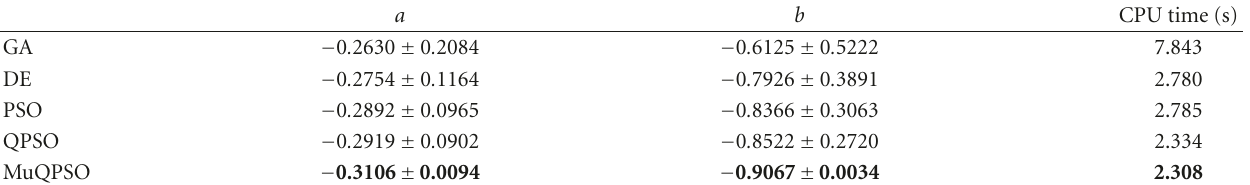
Table 3: Mean values and standard deviations of the filter coe ffi cients in Example 1 (mean of 100 random runs with randomly chosen initial